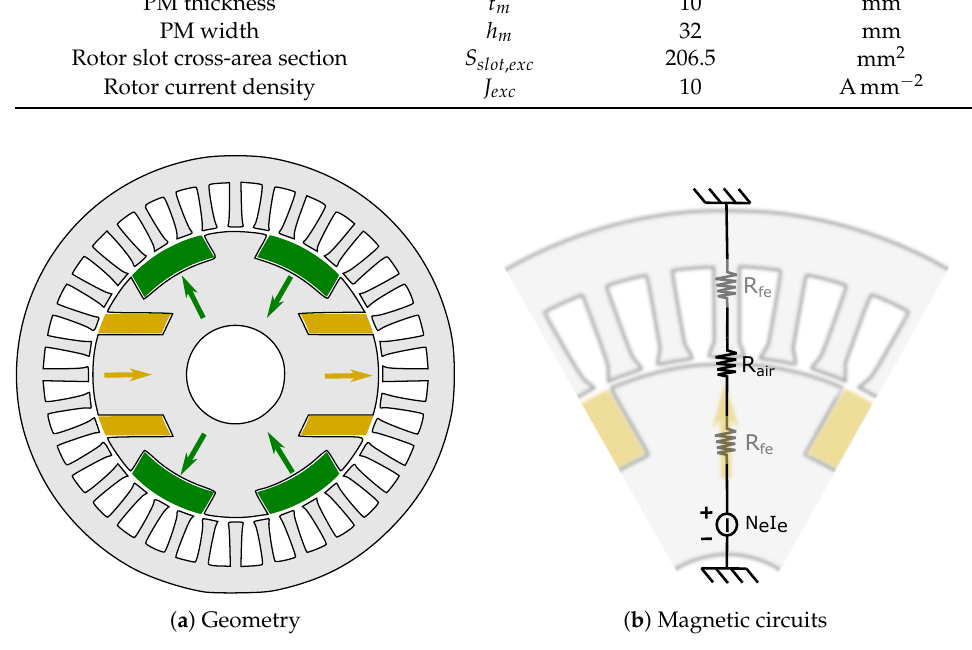
Figure 11. PRC-2 configuration: geometry and magnetic